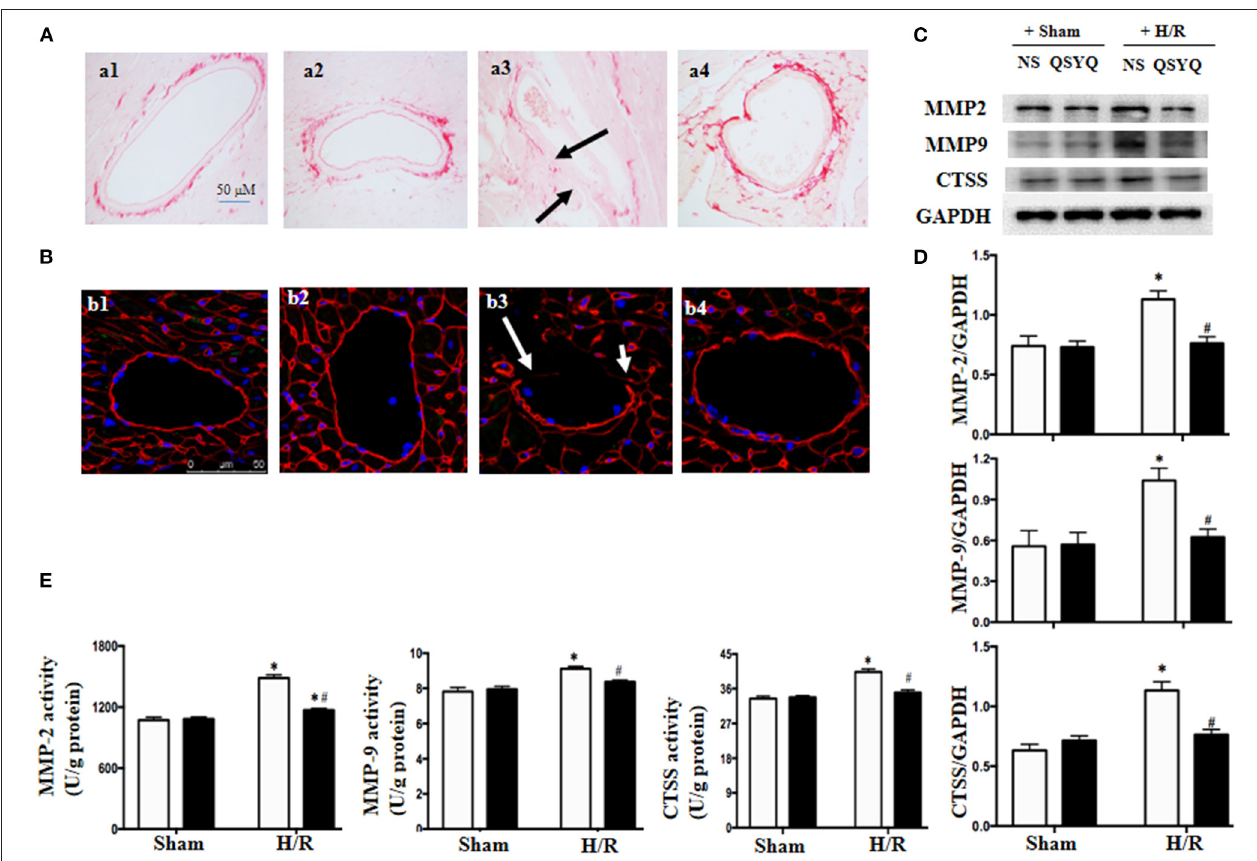
FIGURE 6 | Effect of pretreatment with QSYQ on maintaining the vascular BM integrity and related proteins. (A) Collagen was stained by Sirius Red in different groups to show the collagen deposition in cardiac microvascular BM of rat. Arrows: decreased area of collagen deposition in BM. a1: NS + Sham group; a2: QSYQ + Sham group; a3: NS + I/R group; a4: QSYQ + I/R group. Bar = 50 µ m. (B) Immunofluorescence confocal images of collage-IV (red) in coronary venules of rat in each group. Arrows: discontinuous distribution of collagen IV. b1: NS + Sham group; b2: QSYQ + Sham group; b3: NS + I/R group; b4: QSYQ + I/R group. Bars = 50 µ m. (C,D) Representative western blot bands (C) and relative densitometric values (D) of MMP-2, MMP-9, and CTSS in HCMECs in different groups. GAPDH was used as a loading control. (E) The activity of MMP-2, MMP-9, and CTSS tested by ELISA in different groups of HCMECs. Data are expressed as means ± SEM ( n = 6). * p < 0.05 vs. NS + control group, # p < 0.05 vs. NS + H/R group. Statistical analysis was performed using two-way ANOVA followed by Bonferroni for multiple